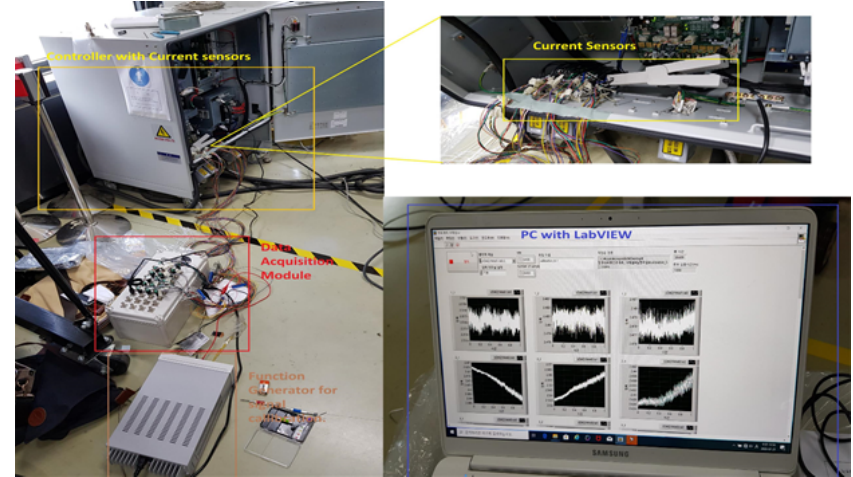
Figure 9. Data acquisition system for the Hyundai robot.